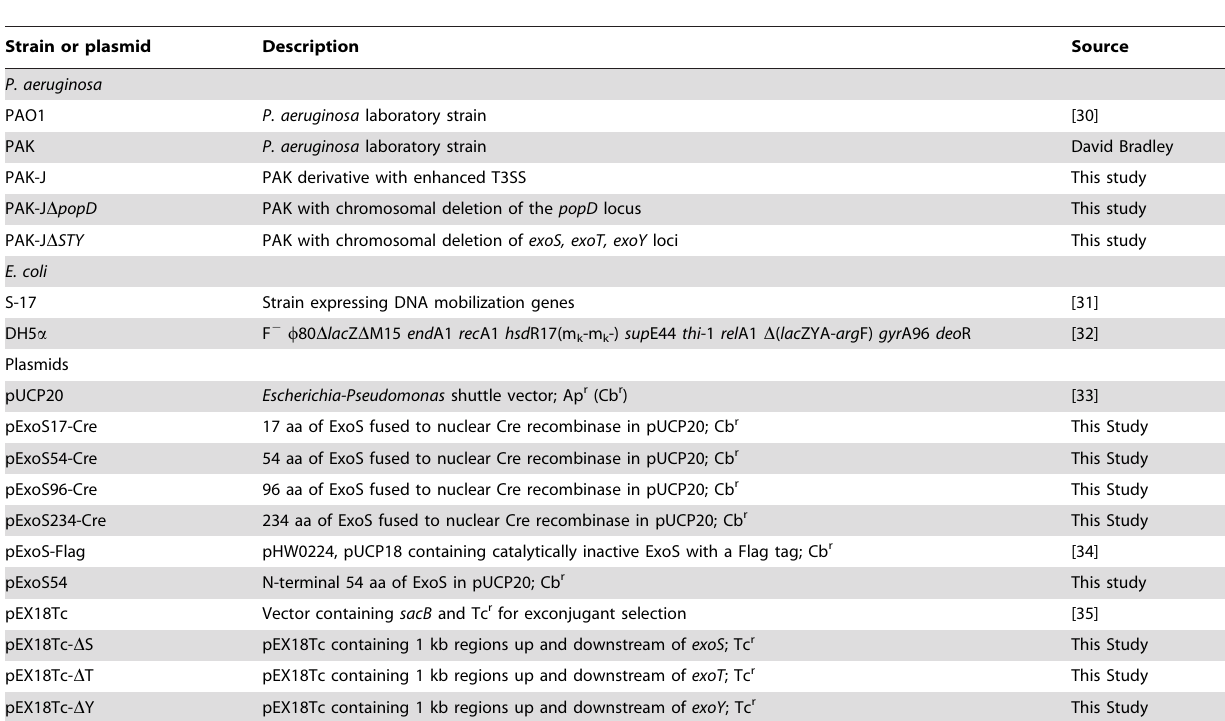
Table 1. Strains and plasmids used in this